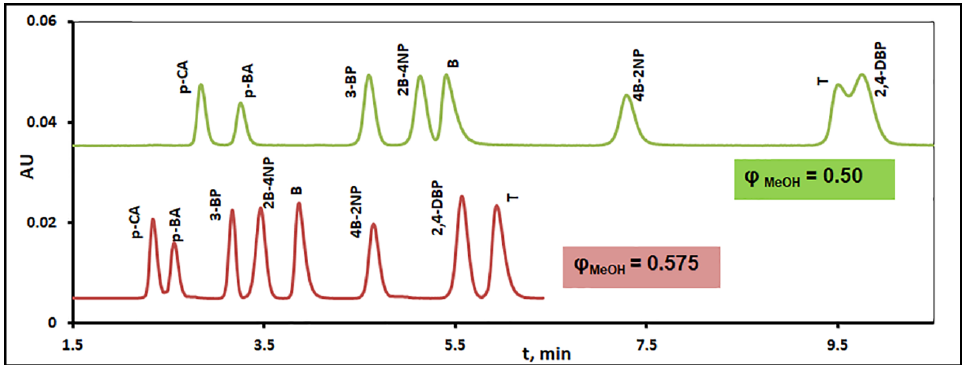
Figure 7. UV detected chromatograms of the mixture of eight ionized and non-ionized solutes obtained on Kinetex 5 µm EVO column under different isocratic conditions in eluent pH = 3 modified